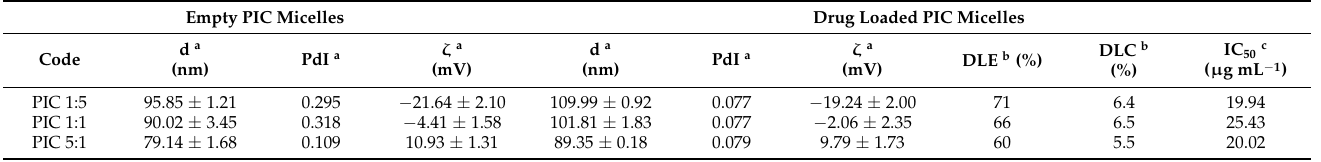
Figure 3. Size-distribution curves ( a ) and zeta potentials ( b ) obtained from DLS measurements of 1 mg mL − 1 aqueous micellar dispersions of polyion complex micelles prepared at different molar ratios between the positively and negatively charged groups: PIC 1:5 (d = 95.85 nm, PdI: 0.295, ζ = − 21.64 mV), PIC 1:1 (d = 90.02 nm, PdI: 0.318, ζ = − 4.41 mV), PIC 5:1 (d = 79.14 nm, PdI: 0.109, ζ = 10.93 mV). Table 2. Characteristics of polyion complex micelles before and after drug loading. Drug Loaded PIC Micelles